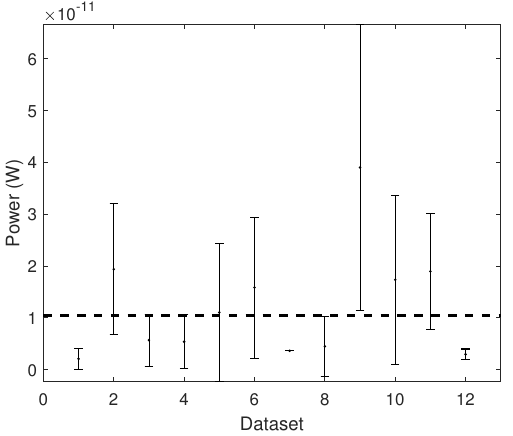
Figure 5. Mean and standard deviation of maximum power for leads across all data sets with the optimized threshold (1.05 × 10 − 11 W) for FLR = 1% developed here shown as a dotted